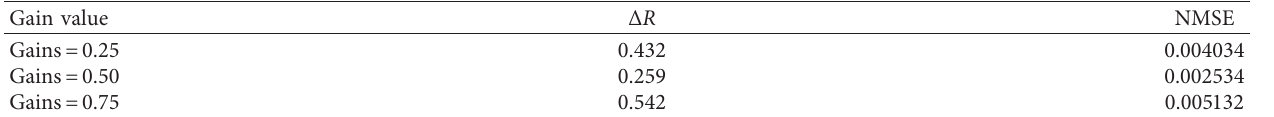
Table 2: Image quality evaluation